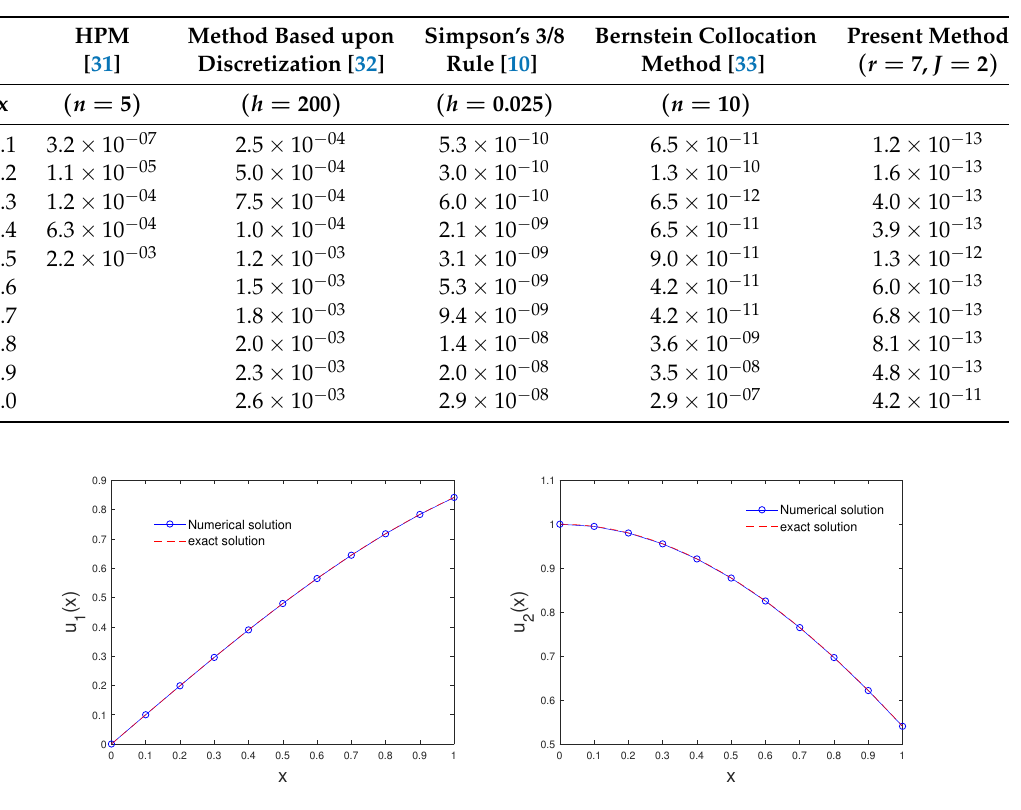
Table 4. The comparison between absolute errors of Example 3 for u 2 .